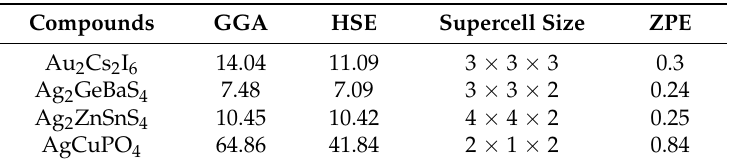
Figure 6. Calculated dielectric function ( a , c ) and optical absorption coefficients ( b , d ) of Au 2 Cs 2 I 6 and Ag 2 GeBaS 4 , respectively, along the x , y , and z directions. Table 4. Calculated static dielectric constants from optical studies for Au 2 Cs 2 I 6, Ag 2 GeBaS 4, Ag 2 ZnSnS 4 , and AgCuPO 4. The supercell size used for the phonon study and the calculated zero-point energy (ZPE) for the studied compounds are also listed